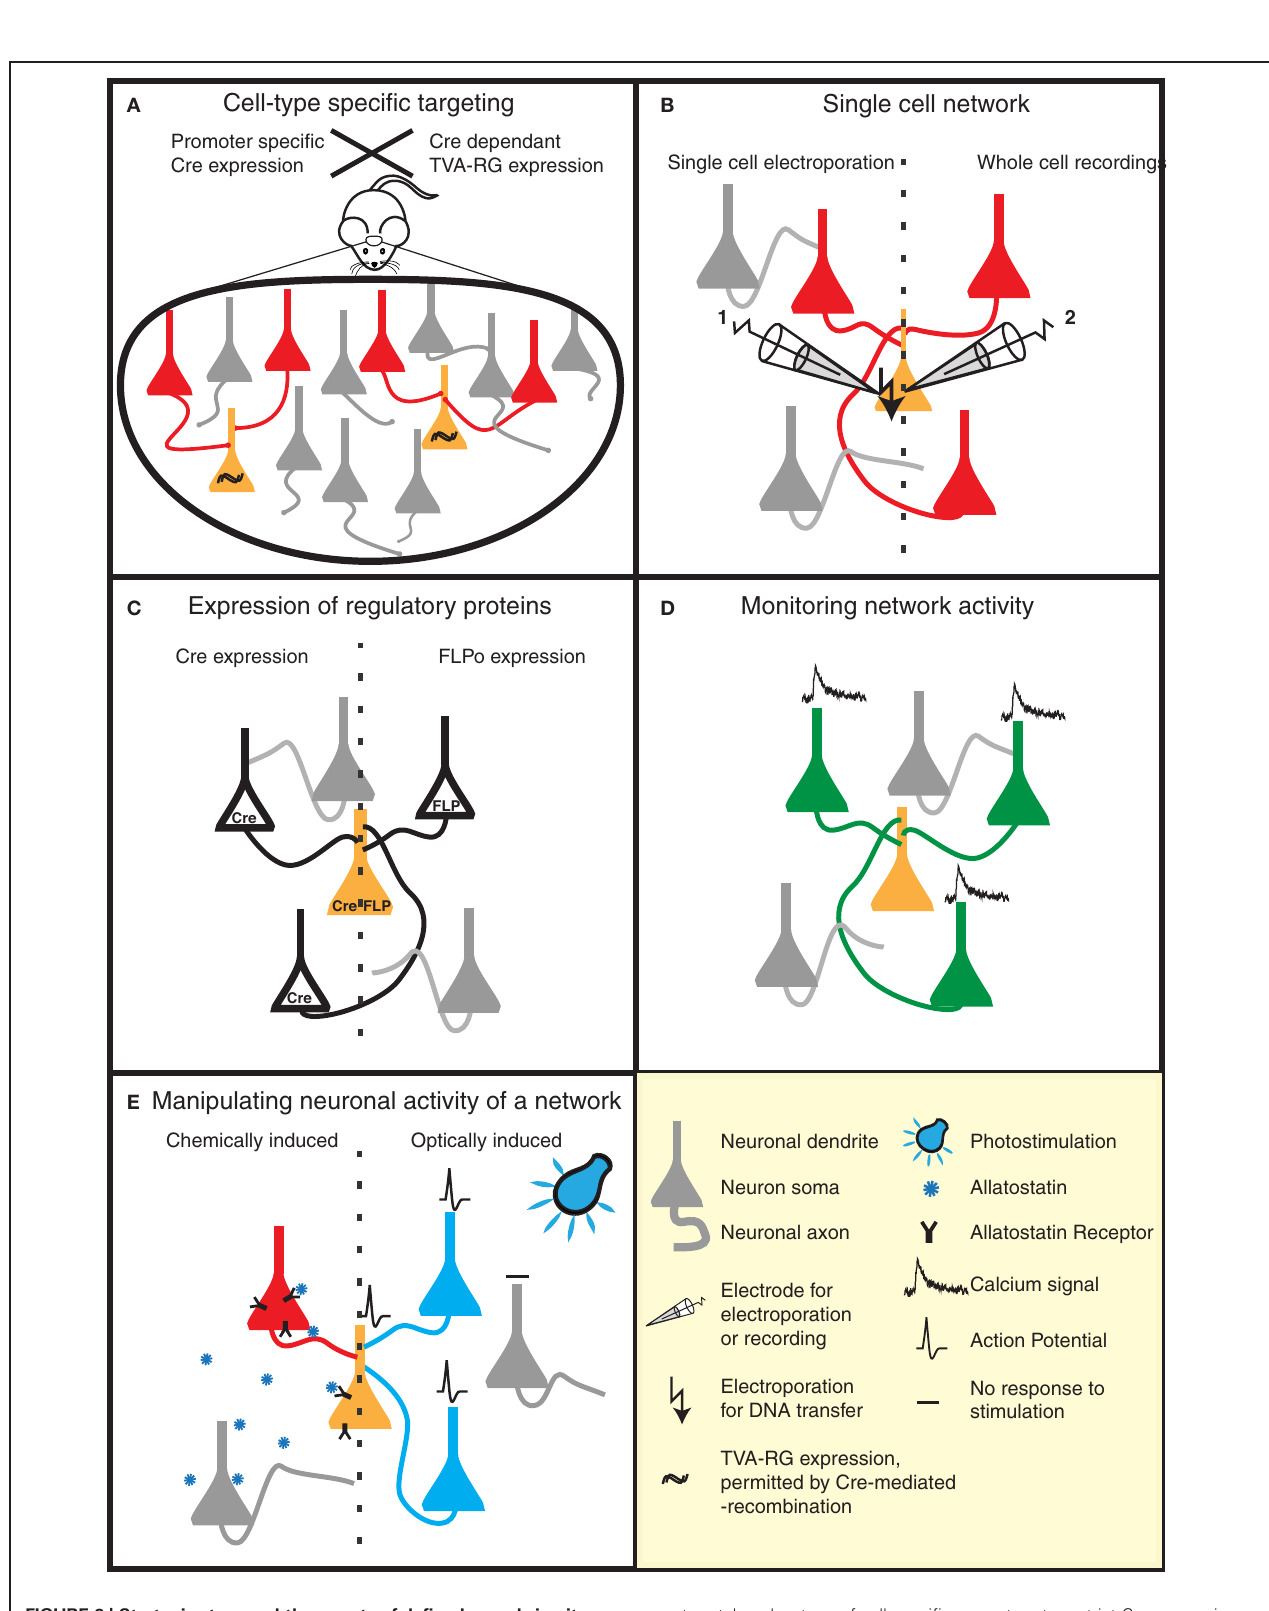
FIGURE 2 | Strategies to reveal the secrets of defined neural circuits. (A,B) There are several strategies to target the rabies infection to individual neurons or specific cell types. (A) Genetic strategies such as the Cre-lox